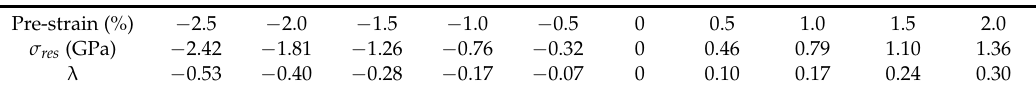
Figure 1. Schematic of nanoindentation atomic configuration with a spherical diamond indenter. Table 1. Pre-strain vs. corresponding residual stress and normalized by the ideal shear strength of Cu single crystals.